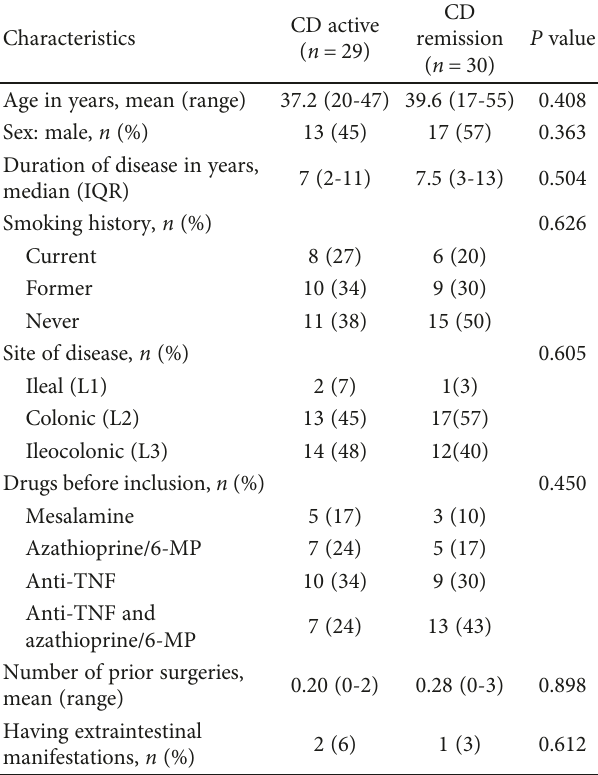
Table 1: General characteristics of 59 patients with CD.